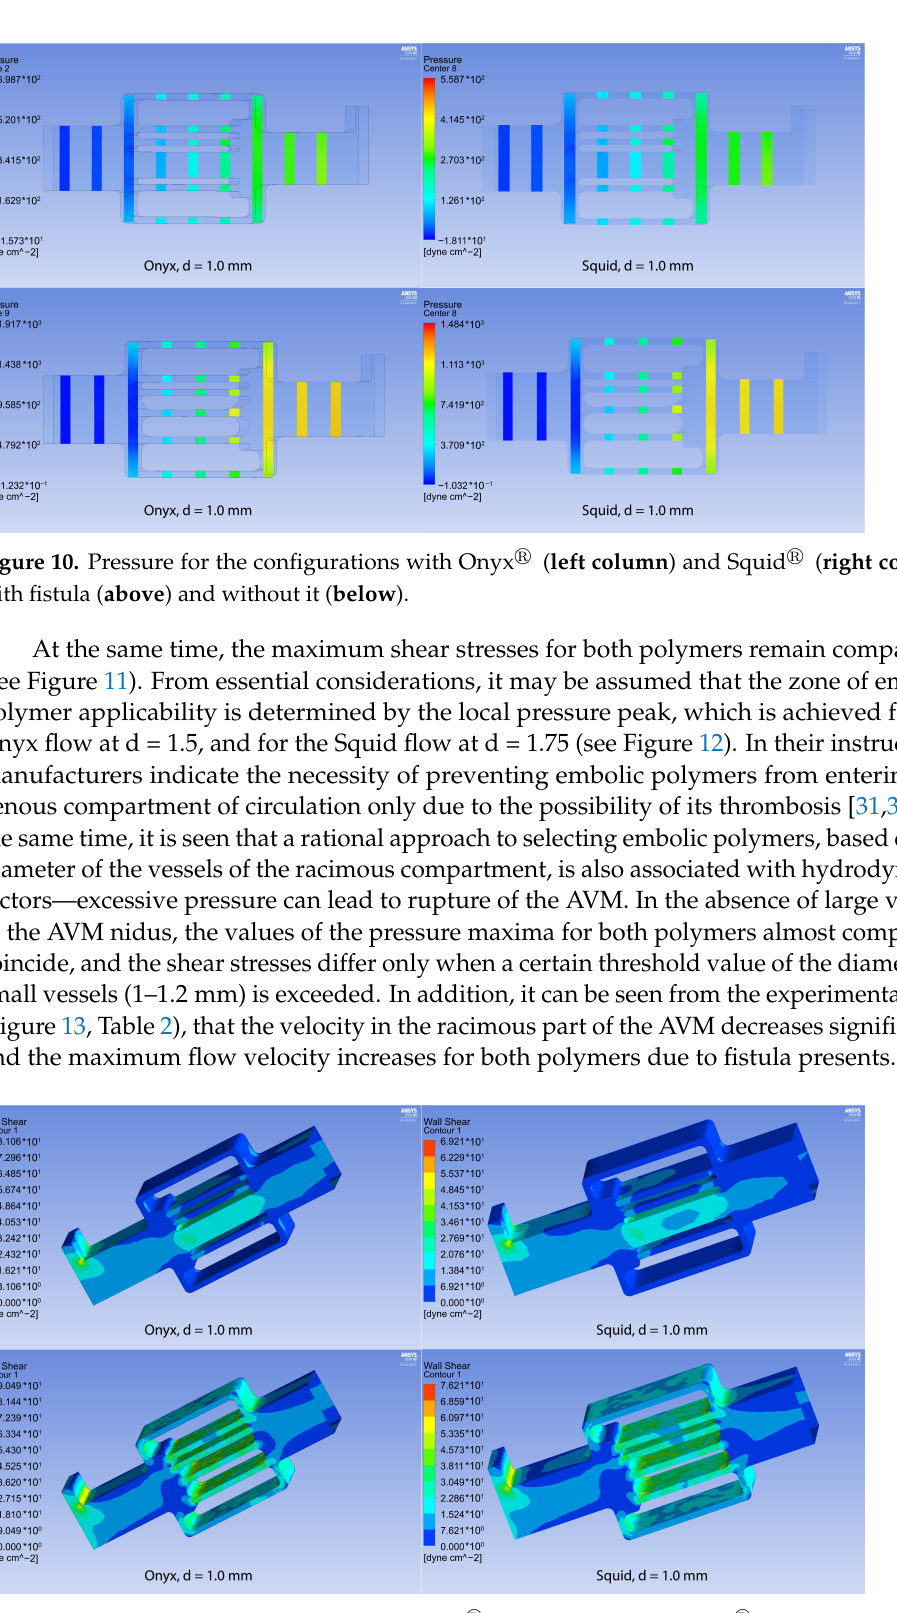
Figure 11. WSS for the configurations with Onyx (cid:114) ( left column ) and Squid (cid:114) ( right column ) with fistula ( above ) and without it ( below